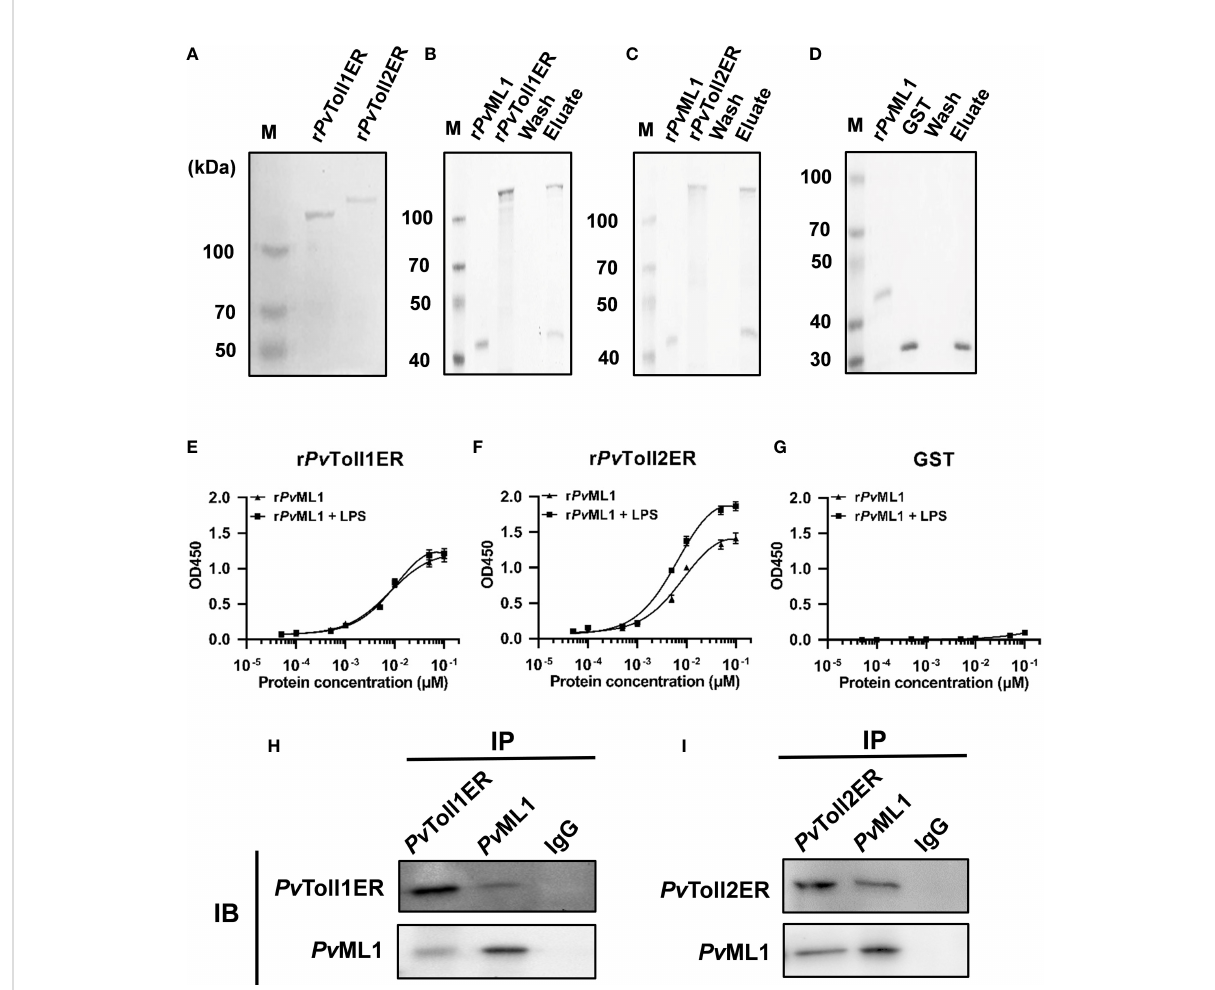
FIGURE 6 Pv ML1 interacted with the extracellular region of Pv Tolls. (A) Recombinant expression and puri fi cation of the extracellular region of Pv Toll1 and Pv Toll2. Pv Toll1ER and Pv Toll2ER were expressed with pGEX-6P-1 vector in E. coli Rosseta (DE3) cells and puri fi ed. (B-D) GST pull-down assay was carried out to test the interaction of Pv ML1 with Pv Tolls. r Pv ML1 and Pv TollERs (r Pv Toll1ER or r Pv Toll2ER) were mixed with Glutathione Sepharose 4B resin, and GST was used as control in this experiment. The results were visualized by coomassie blue staining. Pv ML1 interacted with GST-tagged Pv Toll1ER and Pv Toll2ER but not with GST. (E-G) ELISA was performed to analyze the binding ability of Pv TollERs to Pv ML1. r Pv Toll1ER, r Pv Toll2ER, or GST was used to coat plates. r Pv ML1, or r Pv ML1 plus LPS were serially diluted and added into the coated plates. (H-I) A Co-IP assay was performed to con fi rm the interaction between Pv TollERs and Pv ML1 in cells. Myc-tagged expression plasmid (pcDNA3.1- Pv Toll1ER, or pcDNA3.1- Pv Toll2ER) and EGFP-tagged expression plasmid (pcDNA3.1- Pv ML1-EGFP) were co-transfection into HEK-293T cells, respectively. Anti-cMyc antibody and anti - cGFP antibody were used to analyze the interaction. Normal rabbit IgG was used as the negative